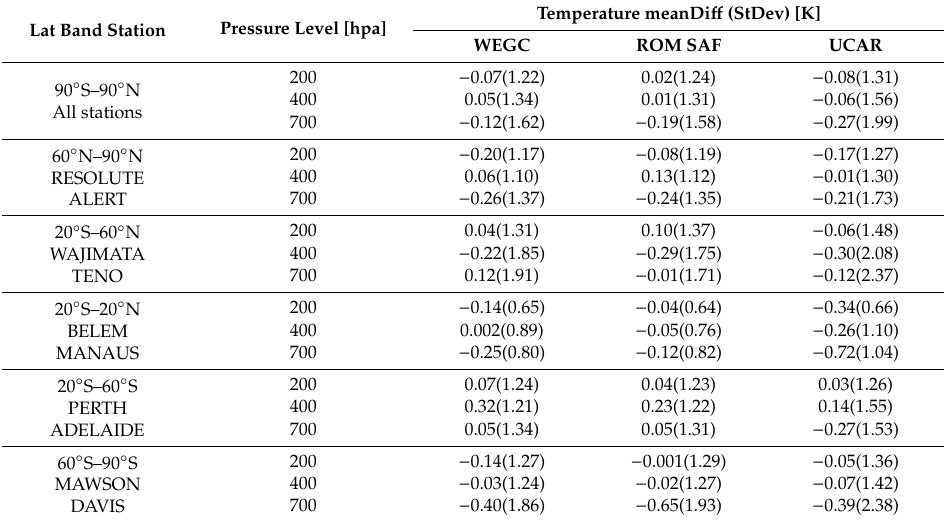
Table 2. Temperature mean di ff erences (meanDi ff ) and corresponding standard deviations (StDev) between RO and RS of the three centers at selected pressure levels of 200, 400 and 700 hPa. Temperature meanDi ff (StDev) [K] Lat Band Station Pressure Level [hpa] WEGC ROM